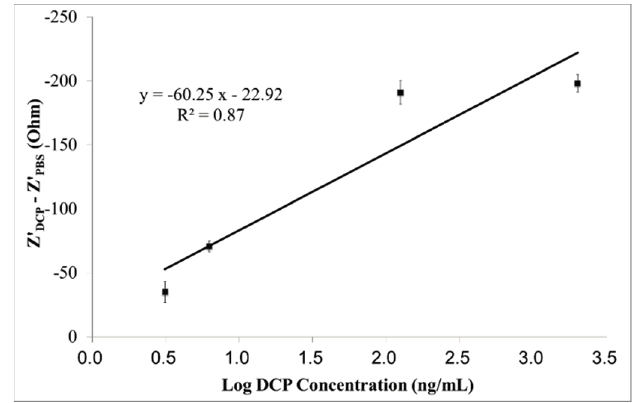
Figure 5. The calibration curve (Z' DCP − Z' PBS vs. Log DCP concentration) of the immunosensor on measuring DCP (3.125–2000 ng/mL) at the optimum measuring frequency of 7.799 kHz, within the specific frequency range (6.887–10 kHz). Results are expressed in mean ± SD (n = 5).